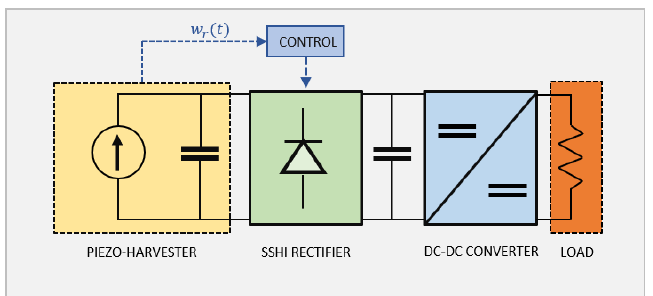
Figure 10. Electrical circuit of the piezoelectric energy generator and the PMU. The piezoelectric harvester is represented as a current generator in parallel with a capacitor [9], whereas the electric load is represented by a